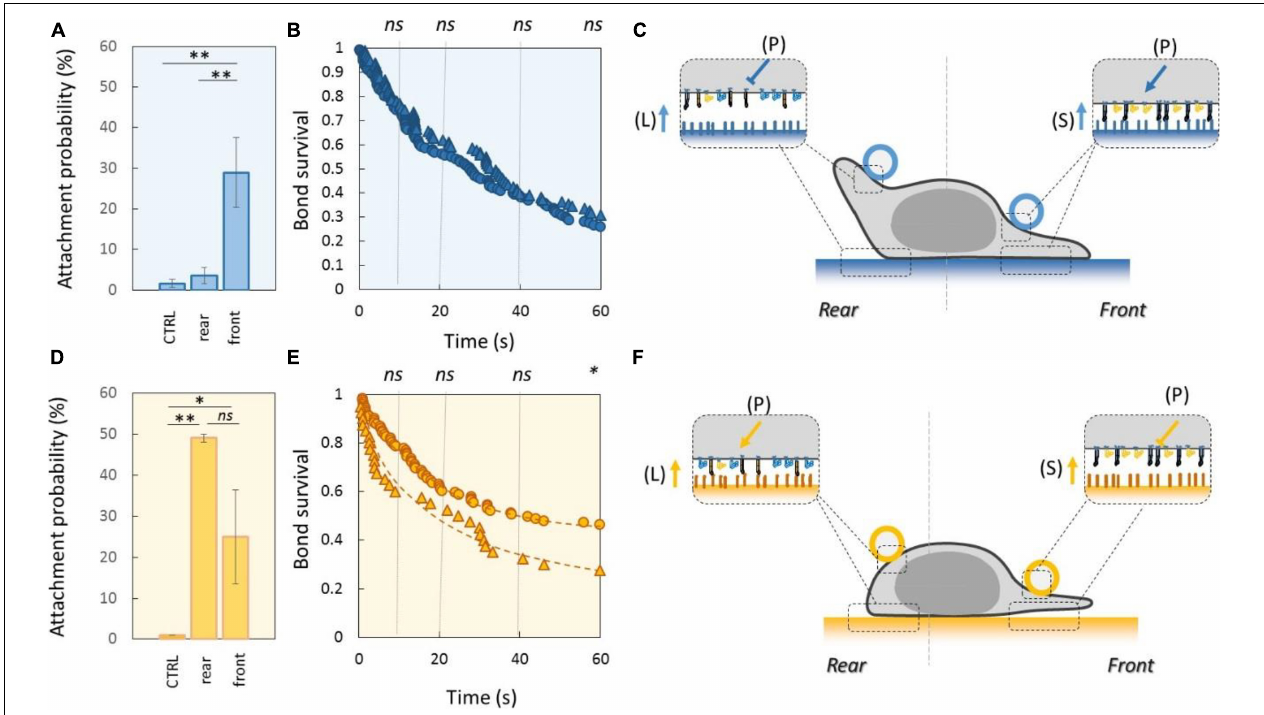
FIGURE 3 | Polarization signaling triggers higher affinity of LFA-1 in leading edge and of VLA-4 in trailing edge. (A–C) Relate to beads and substrates coated with ICAM-1. (D–F) Relate to beads and substrates coated with VCAM-1. All substrates were coated with a CAM density of 1200 molecules. µ m − 2 . (A,D) Attachment probability of beads with CAM densities of 2400 molecules. µ m − 2 on the rear and front of crawling cells. Controls (CTRL) correspond to data with control beads coated with IgG. Independent experiments Nexp = 4 in A and Nexp = 3 in D. Nevents_per_experiment > 40. (B,E) Survival curves of bead attached on cell rear (circles) or cell front (triangles). Blue dots refer to beads and substrates coated with ICAM-1, and orange dots to beads and surfaces coated with VCAM-1. Ligands density on beads was 2400 molecules. µ m − 2 for ICAM-1 and 480 molecules. µ m − 2 for VCAM-1. Nexp = 5, Nevents_per_exp > 90 (in B), Nexp = 4 (in E), Nevents_per_exp > 60 (in E). (C,F) Cartoons illustrating integrin control revealed in precedent data. Integrins are represented in orange for VLA-4 and blue for LFA-1, in their high-affinity and extended conformation (filled) and low-affinity bended conformation (hollow). Coatings on beads and substrates are colored in blue for ICAM-1 and orange for VCAM-1. Arrows indicate relative activating effect and T bars inhibiting effects for LFA-1 (orange) and VLA-4 (blue). Letter in bracket (P) indicates that signal originates from internal misopolarization. Error bars are standard deviations for independent experiments. ∗ P < 0.05 and ∗∗ P < 0.01, with respect to unpaired Student t -test. In B and E, statistical tests were performed at 10, 20, 40, and 60 s (dashed lines) and results indicated above the